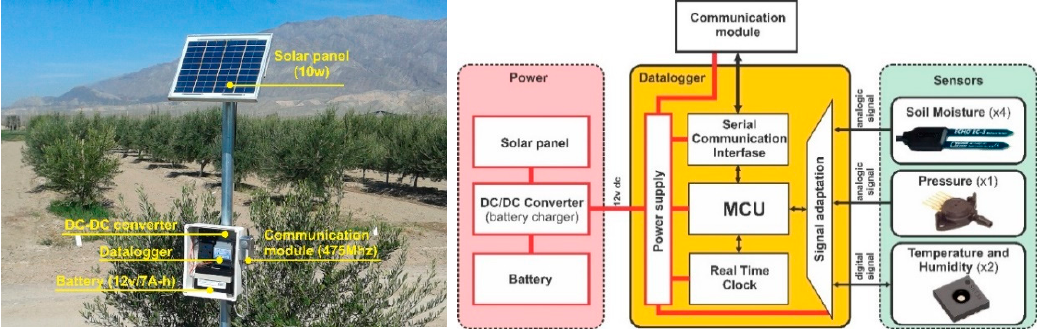
Figure 2. Components of an in-field measurement station.